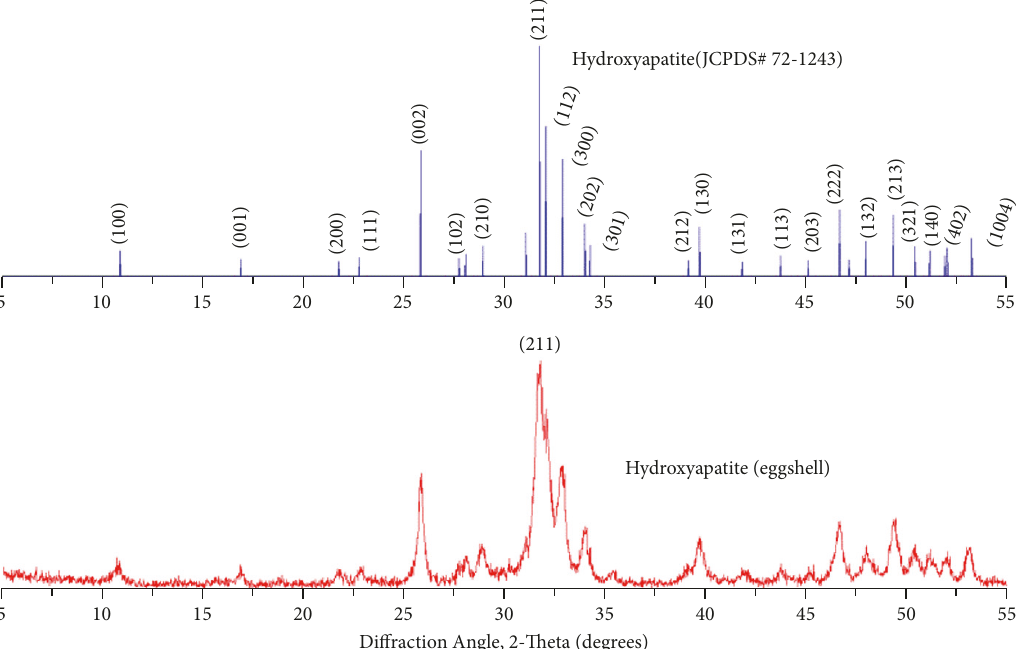
Figure 1: X-ray diffraction results of eggshell nanohydroxyapatite nanoparticles synthesized from eggshell compared with hydroxyapatite (JCPDS number 72-1245).